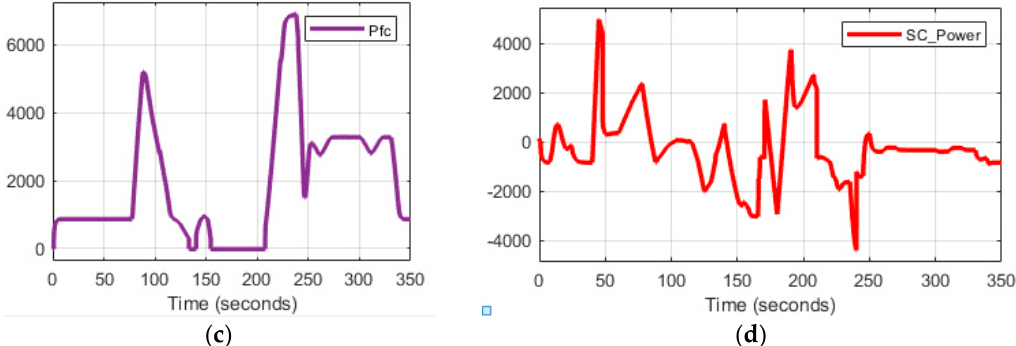
Figure 18. ( a ) Line voltage, ( b ) phase current, ( c ) fuel cell power, ( d ) SC Power.